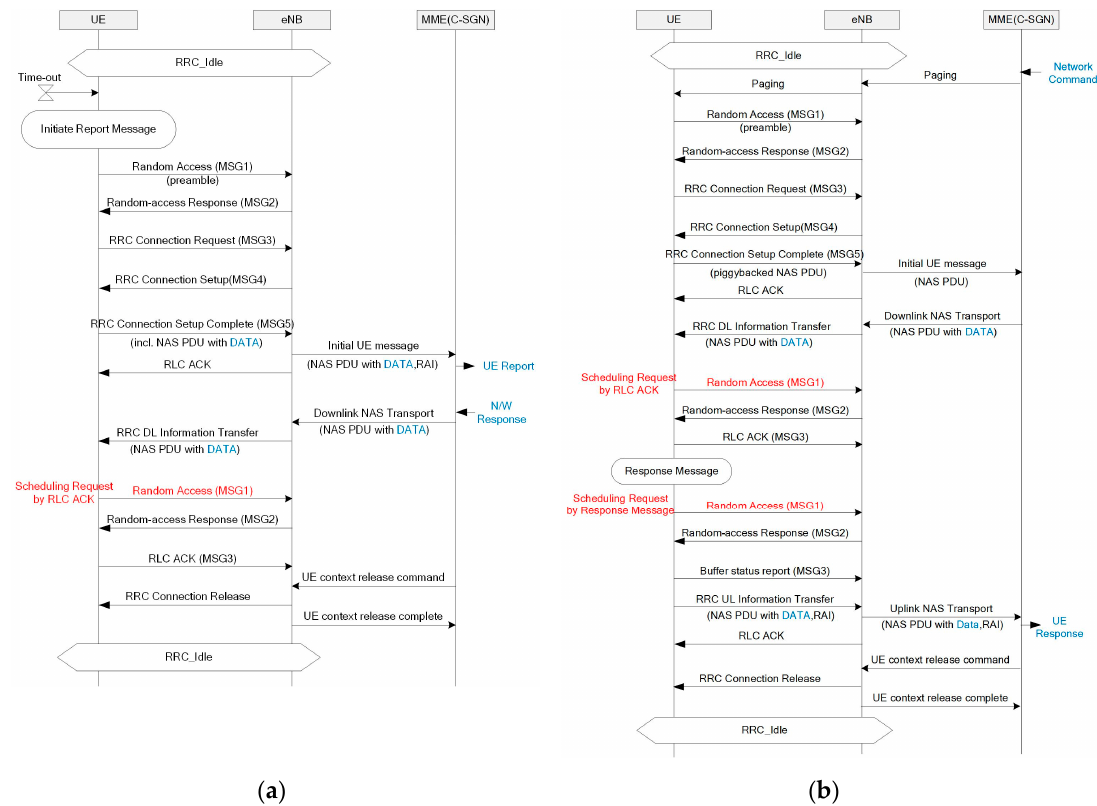
Figure 9. Handshake scenario: ( a ) UE report with network response; ( b ) network command with UE response.